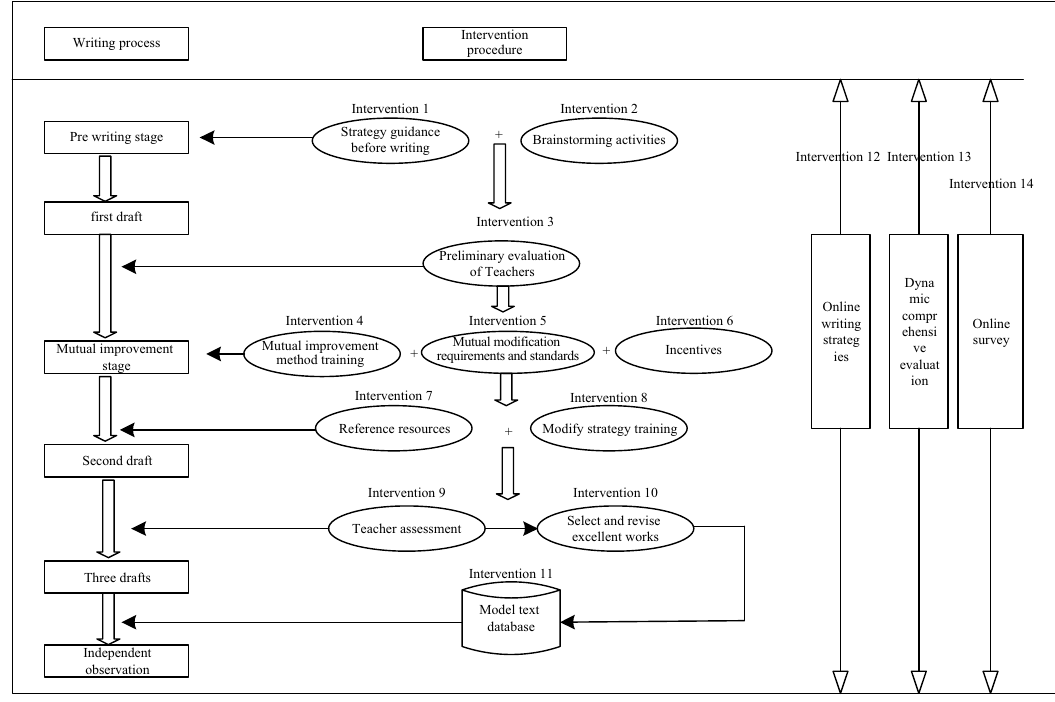
Figure 3: The procedure fl ow of dynamic assessment of English writing based on AI